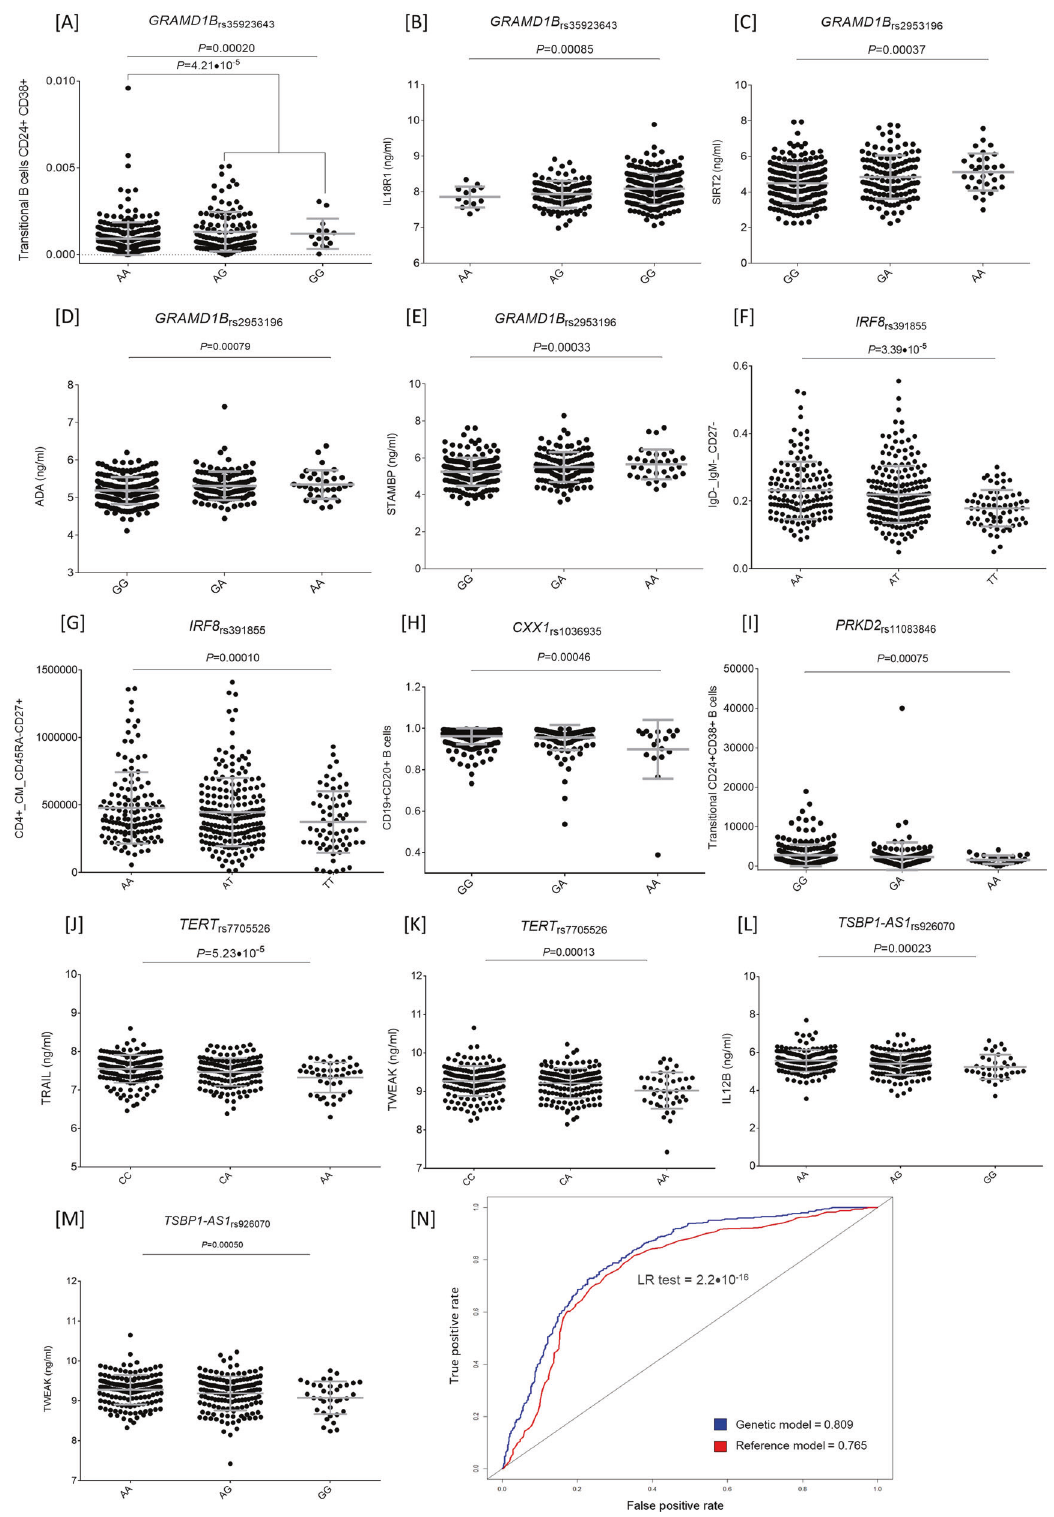
Fig. 1 Functional characterization of GWAS-identi fi ed variants for CLL (A – M) and receiver operating characteristic (ROC) curve analysis (N). Correlation between functional data and GWAS-identi fi ed SNPs was evaluated by linear regression analysis adjusted for age and sex. ROC curve summarizes the accuracy of prediction for each particular model. The model including SNPs signi fi cantly associated with the risk of developing CLL and demographic variables (marked in blue) showed a signi fi cantly improved predictive capacity compared with a reference model including only age and gender as covariates (marked in red). AUC = 0.809 vs. AUC = 0.765; N = 2123 subjects; LR test = 2.2 × 10 − 16